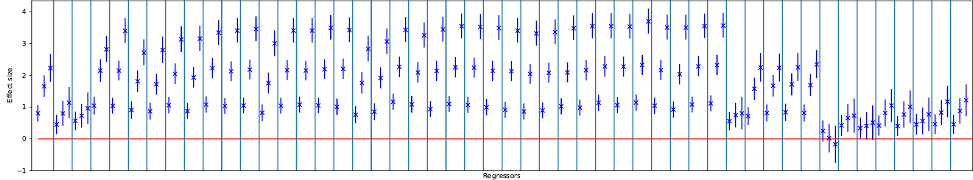
Figure 12. Coefficient confidence intervals for the racePctBlack regressors (first 50 models) in the experiment with support 0.09 and confidence 0.9. Variable racePctBlack can assume four values, namely [ 0,0.035 ] , [ 0.035,0.165 ) , [ 0.165,0.375 ]) , [ 0.375,1 ] . The baseline value used in the regression model is [ 0,0.035 ]